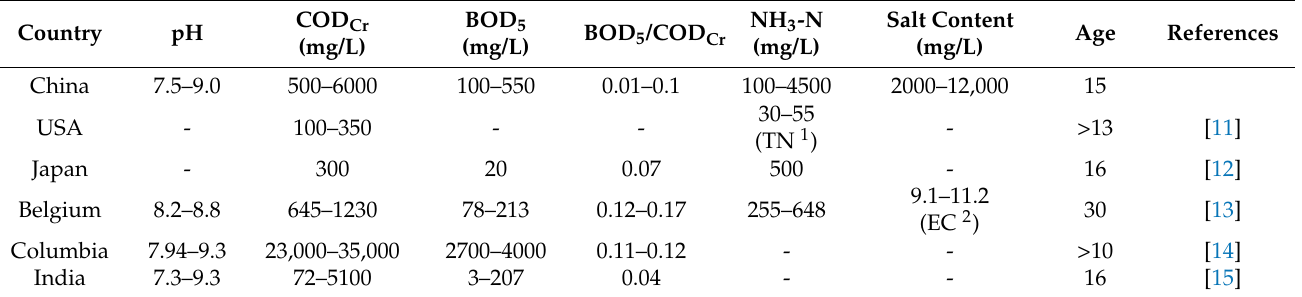
Table 2. Leachate characteristics in late-stage landfills (more than 10 years) of different